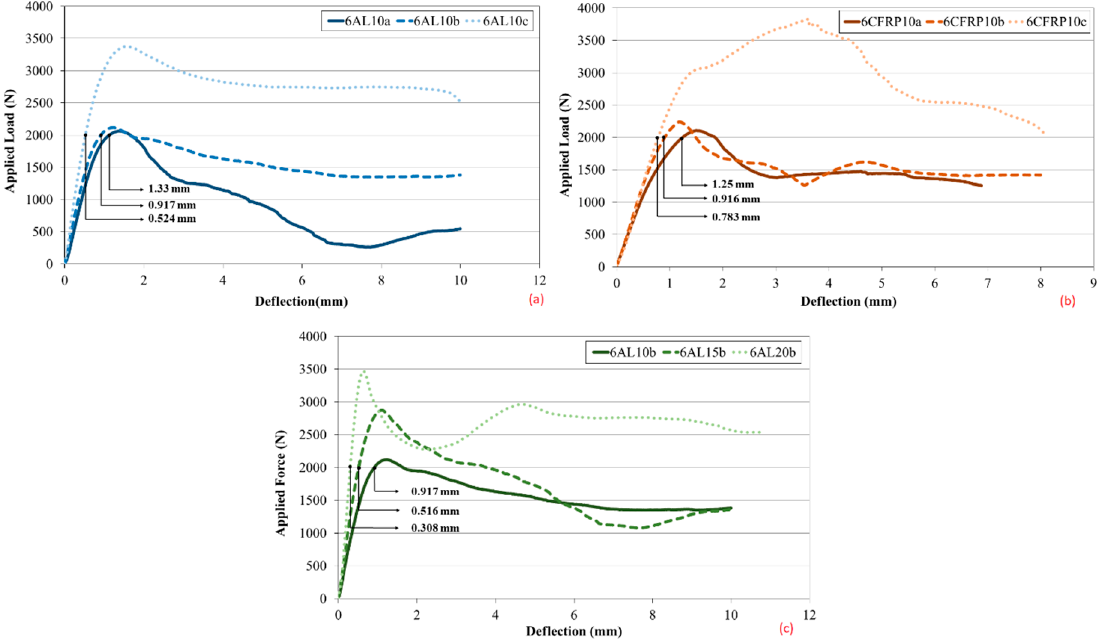
Figure 6. Effect of ( a ) face sheet thickness, ( b ) face sheet type and ( c ) core height on flexural strength.